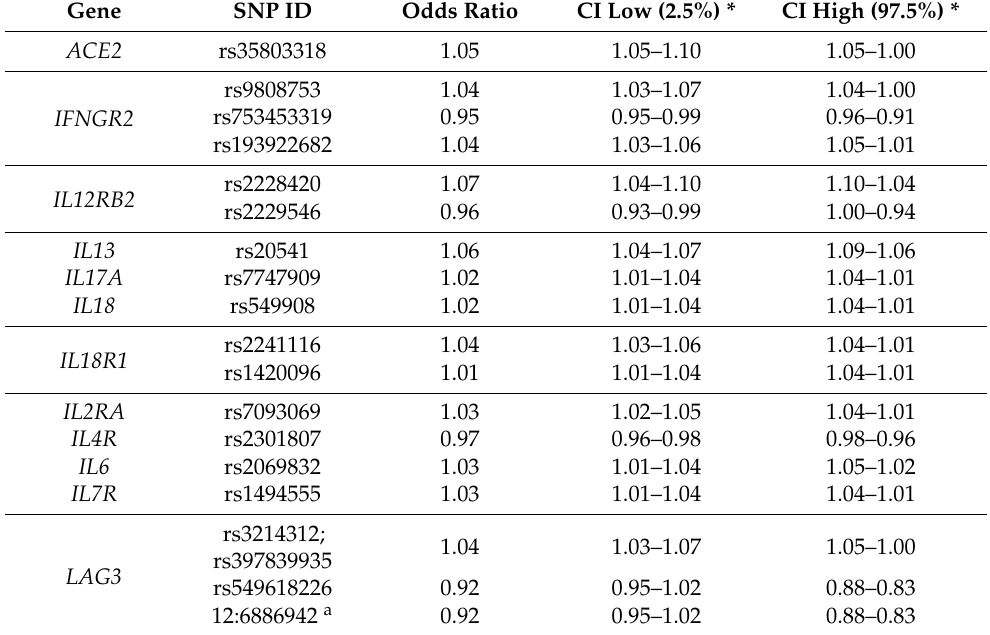
Table 3. Results of the odds ratio calculation on multivariate analysis were applied to the statistically significant variables representing useful predictors. Calculations were performed on the final model with 10% increment steps across the entire predictor